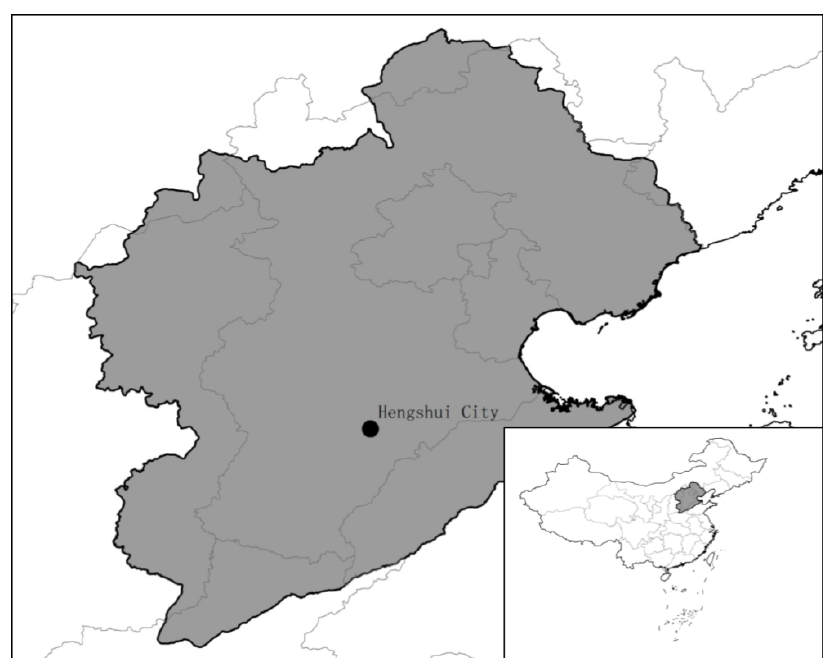
Figure 1. Location of the Haihe River Basin and the surveyed irrigation